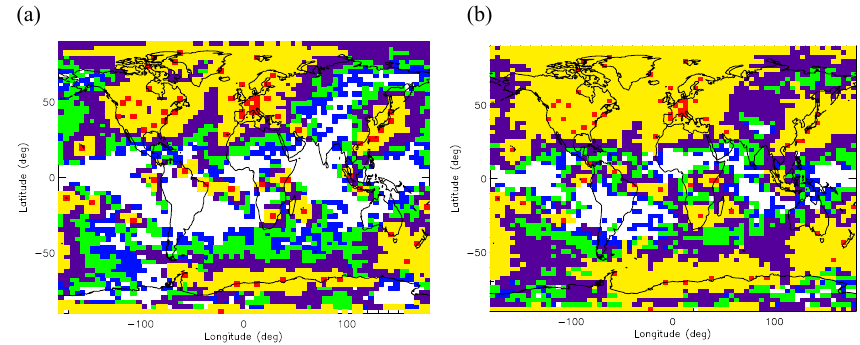
Figure 1: Spatial coverage of 1 day (yellow squares), 2 day (purple squares), 3 day (green squares), Fig. 1. Spatial coverage of 1-day (yellow squares), 2-day (purple squares), 3-day (green squares), and 4-day (blue squares) trajectories in and 4 day (blue squares) trajectories in April for (a) 0.5 km altitude above the surface b) 5.5 km April for (a) 0.5km altitude above the surface (b) 5.5km above sea level. The red squares denote the actual locations of the ozonesonde stations. above sea level . The red squares denote the actual locations of the ozonesonde stations.